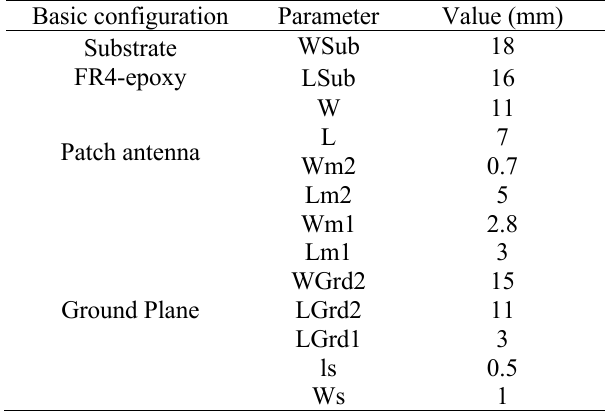
Fig. 6. S 11 optimization for different values of d Table 1: Parameters values of proposed